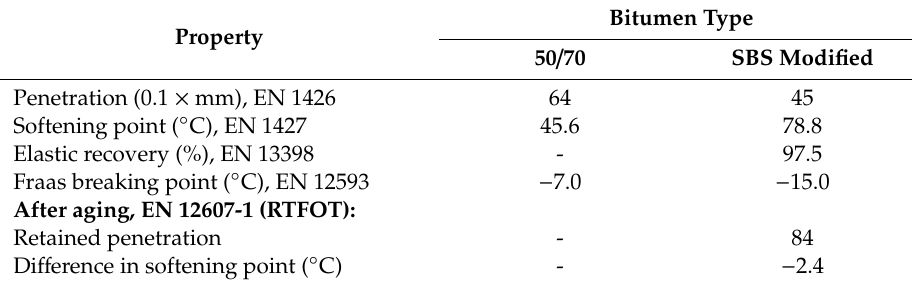
Table 3. Bitumen characterization